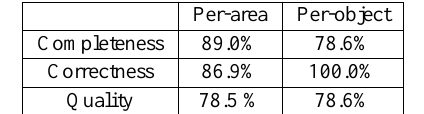
Figure 7: Left: Evaluation of the building detection results on a per-pixel level for the data set Vaihingen . Yellow color denotes true positive pixels. Red color denotes false positive pixels and blue false negative pixels. Middle: Result of the plain segmen- tation obtained by our method, to be compared to Fig.4, right. Right: Absolute difference between ground truth and the DSM obtained after building reconstruction algorithm. Table 1: Quality metrics of the building detection results.